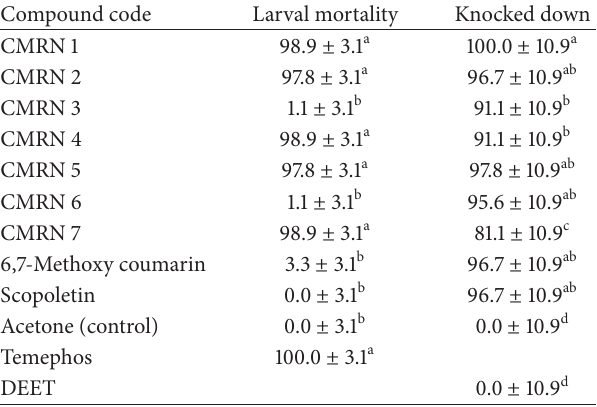
Table 2: Mortality of Anopheles arabiensis larvae exposed to coumarins and halogenated coumarins at 4 𝜇 g/mL and their nega- tive (acetone) and positive (Temephos) controls and adult knock- down activity after 2-minute exposure to halogenated coumarins at 1000 𝜇 g/mL and their negative (acetone) and positive (DEET) controls against repellence assays (adjusted means and standard